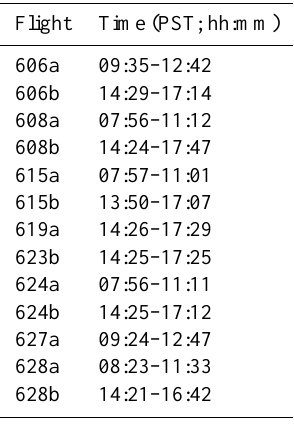
Figure 1. Map of sampling region, showing composite ground track for SW flights. Five transects more or less perpendicular to the boundary layer wind direction are indicated. Adapted from Zaveri et al. (2012).